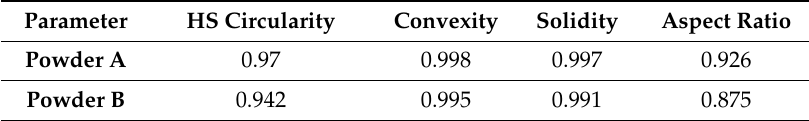
Table 3. Calculated morphological parameters for Powders A and B.